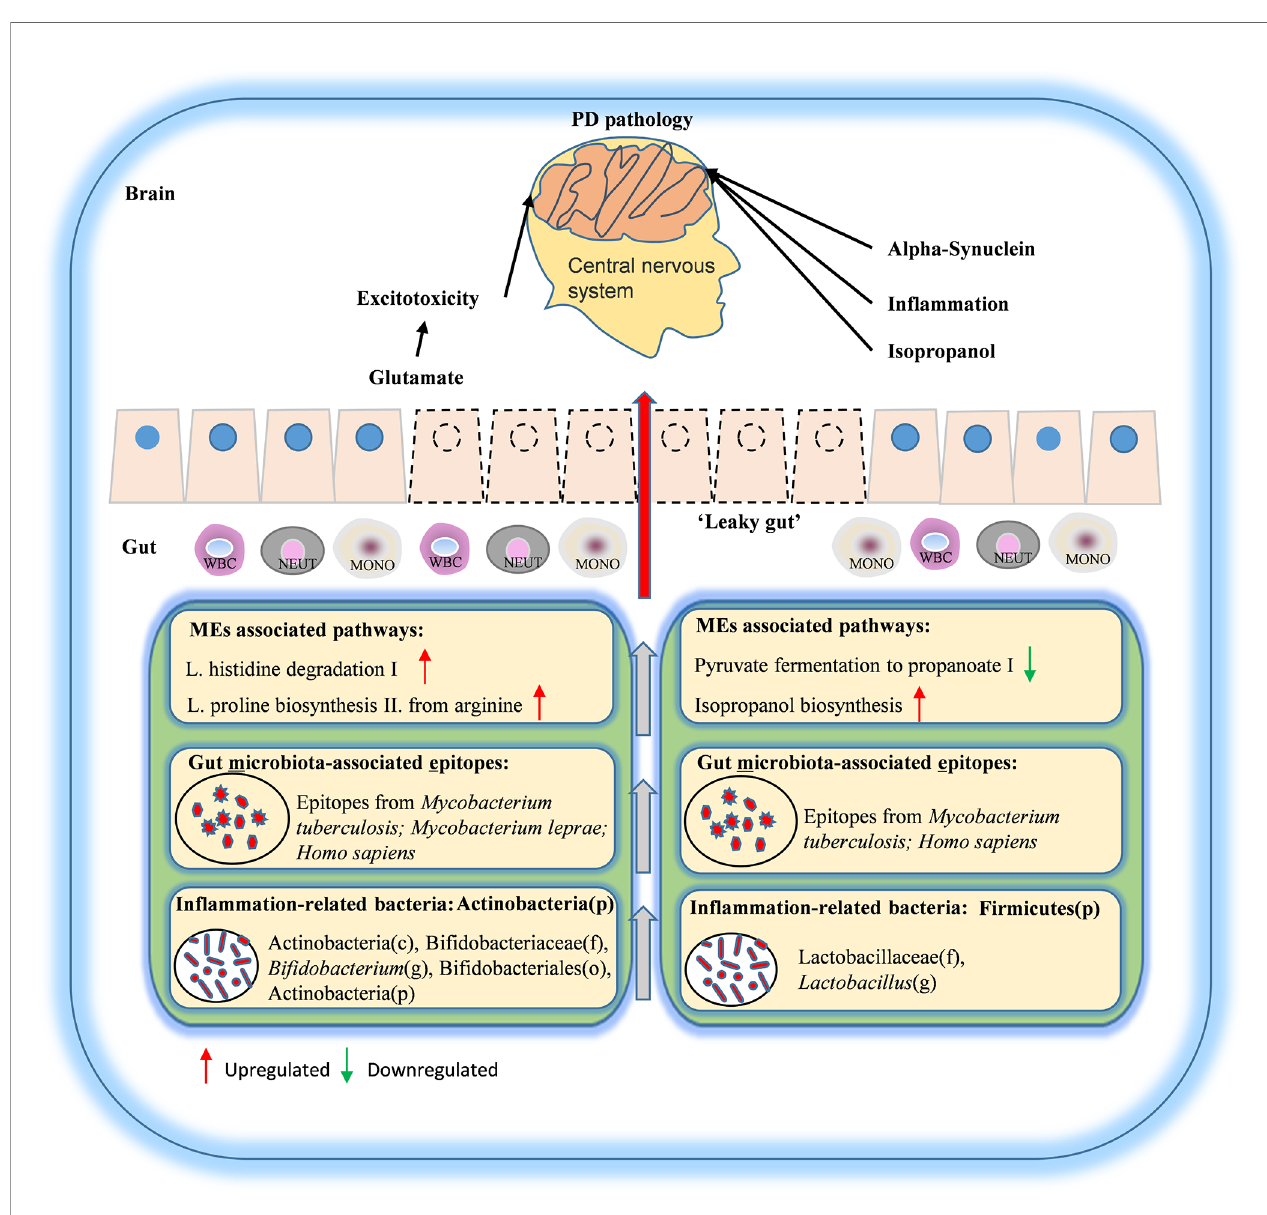
FIGURE 7 | Schematic diagram of correlation of gut MEs with PD